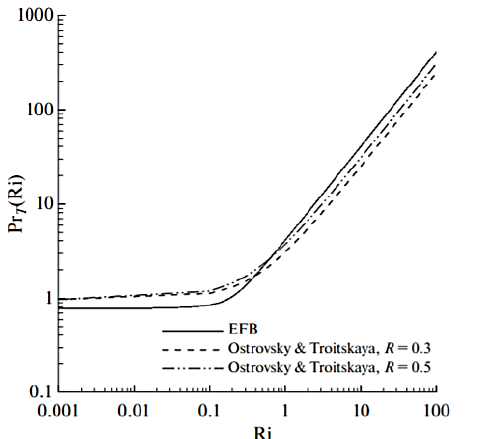
Figure 2. Dependence of the Prandtl number on the Richardson number from the EFB model [23,24] and the model by Ostrovsky and Troitskaya [22].